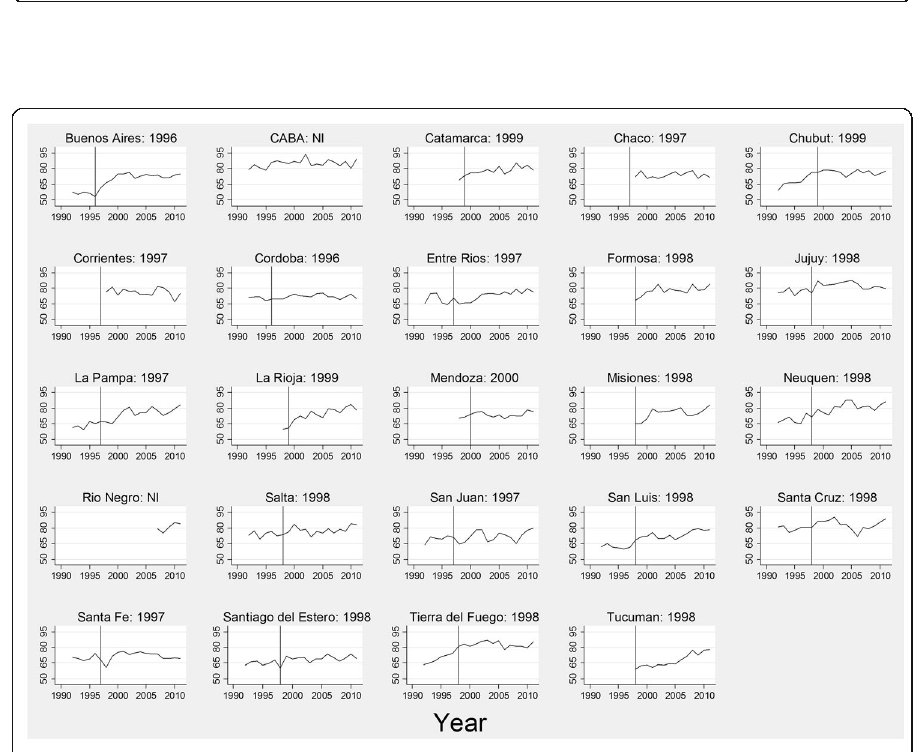
Fig. 6 Gross enrollment rates and implementation of education reform, by province. Argentina, 1992 – 2011 (teenagers aged 15 – 19 attending any educational level, %). Notes: NI not implement, CABA City of Buenos Aires (Federal District). Vertical lines indicate year of implementation of LFE by province. Source: Argentina Household Survey EPH - SEDLAC (CEDLAS and The World Bank) and Crosta (2007); own